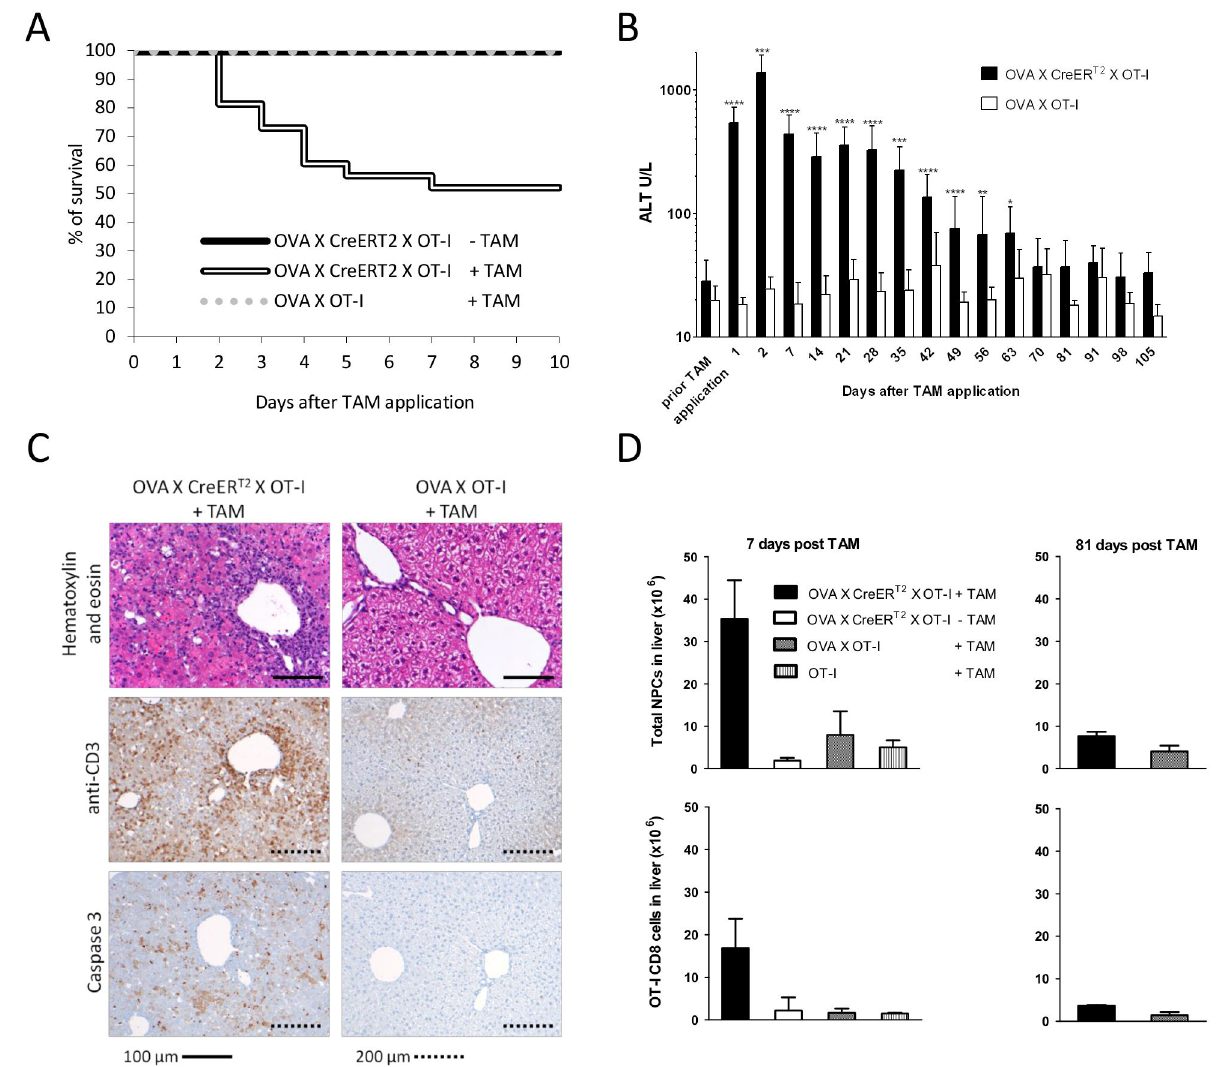
Figure 3. Induction of hepatocyte-specific antigen expression in OVA X CreER T2 X OT-I